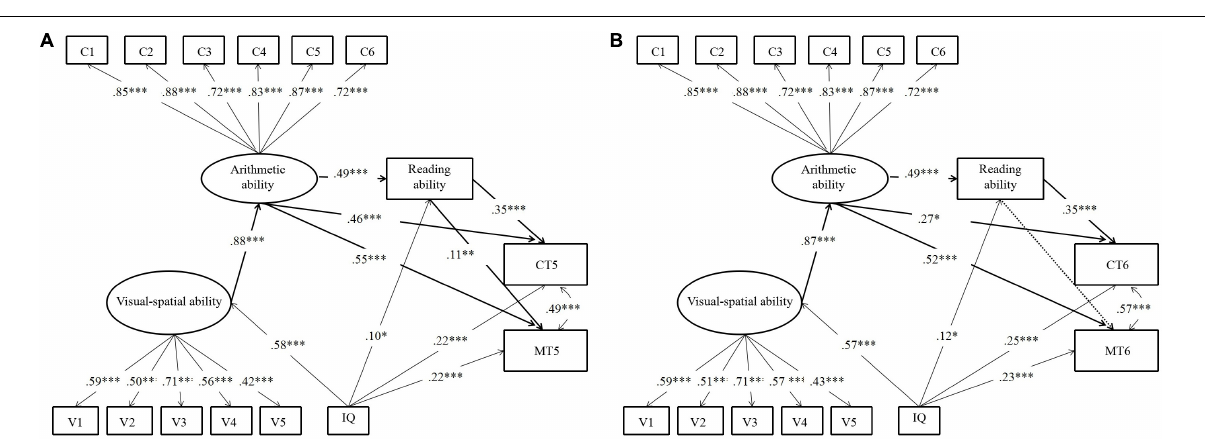
arithmetic ability to MT5 ( β = 0.55, p < 0.001), reading